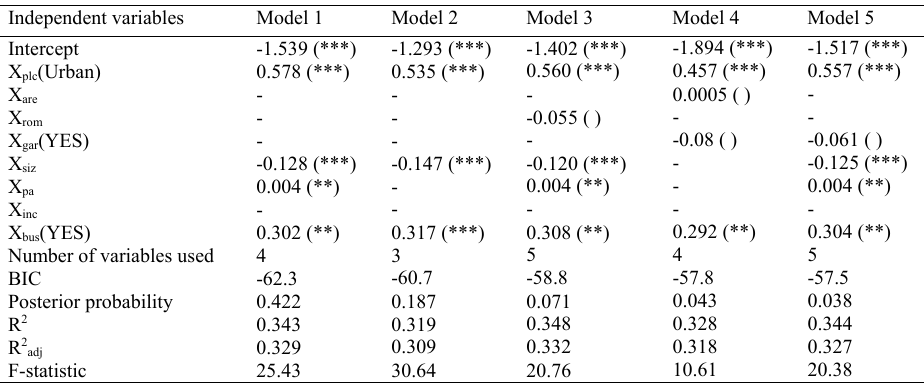
Table 2: Best models as selected by the Bayesian Model Average method